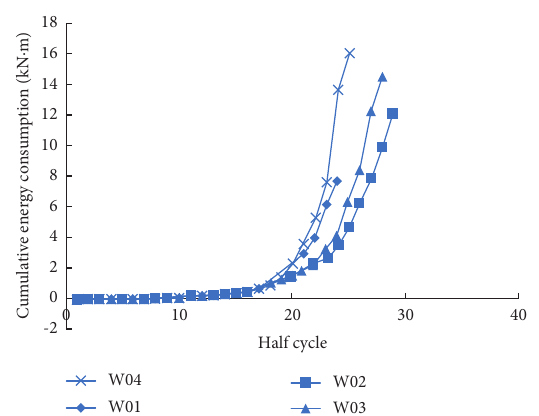
Figure 10: Cumulative energy